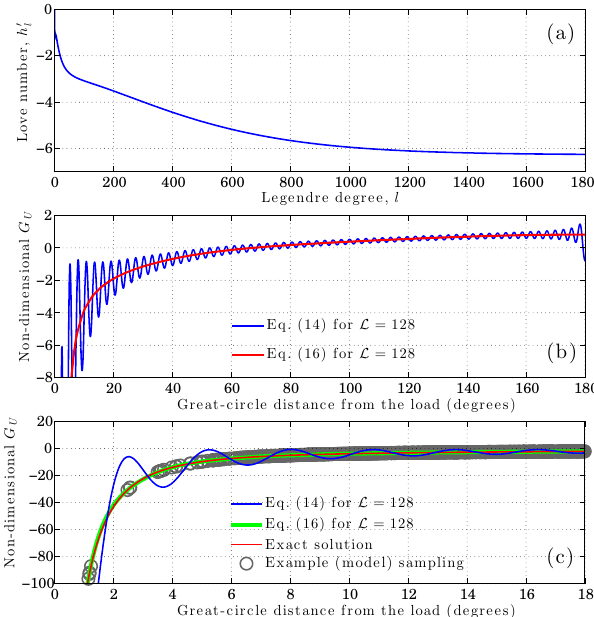
Figure 2. Parameterization of (elastic) solid-earth deformation caused by surface loading. (a) Load Love numbers, h (cid:48) , up to 1800 l Legendre degree. As l → ∞ , h (cid:48) converges slowly toward a constant l value. (b) Non-dimensional Green’s function, G U , computed by truncating the series at L = 128. The conventional approximation (Eq. 14) produces noise, with greater amplitudes near the loading point. The problem is avoided by using the approximation given by Eq. (16). (c) Demonstration of model ability to accurately parame- terize G U . Solutions obtained by truncating the series (according to Eq. 16) at L = 128 are virtually the same as exact solutions (at least beyond ≈ 1 ◦ from the load), and these are accurately sampled by our model at an example vertex due to unit loads applied at the el- emental centroids of the mesh (circles in the figure). (See Sect. 3.1 for the explanation of the exact solution.) For comparison, solu- tions associated with Eq. (14) illustrate the ability of contemporary pseudo-spectral models to parameterize G U